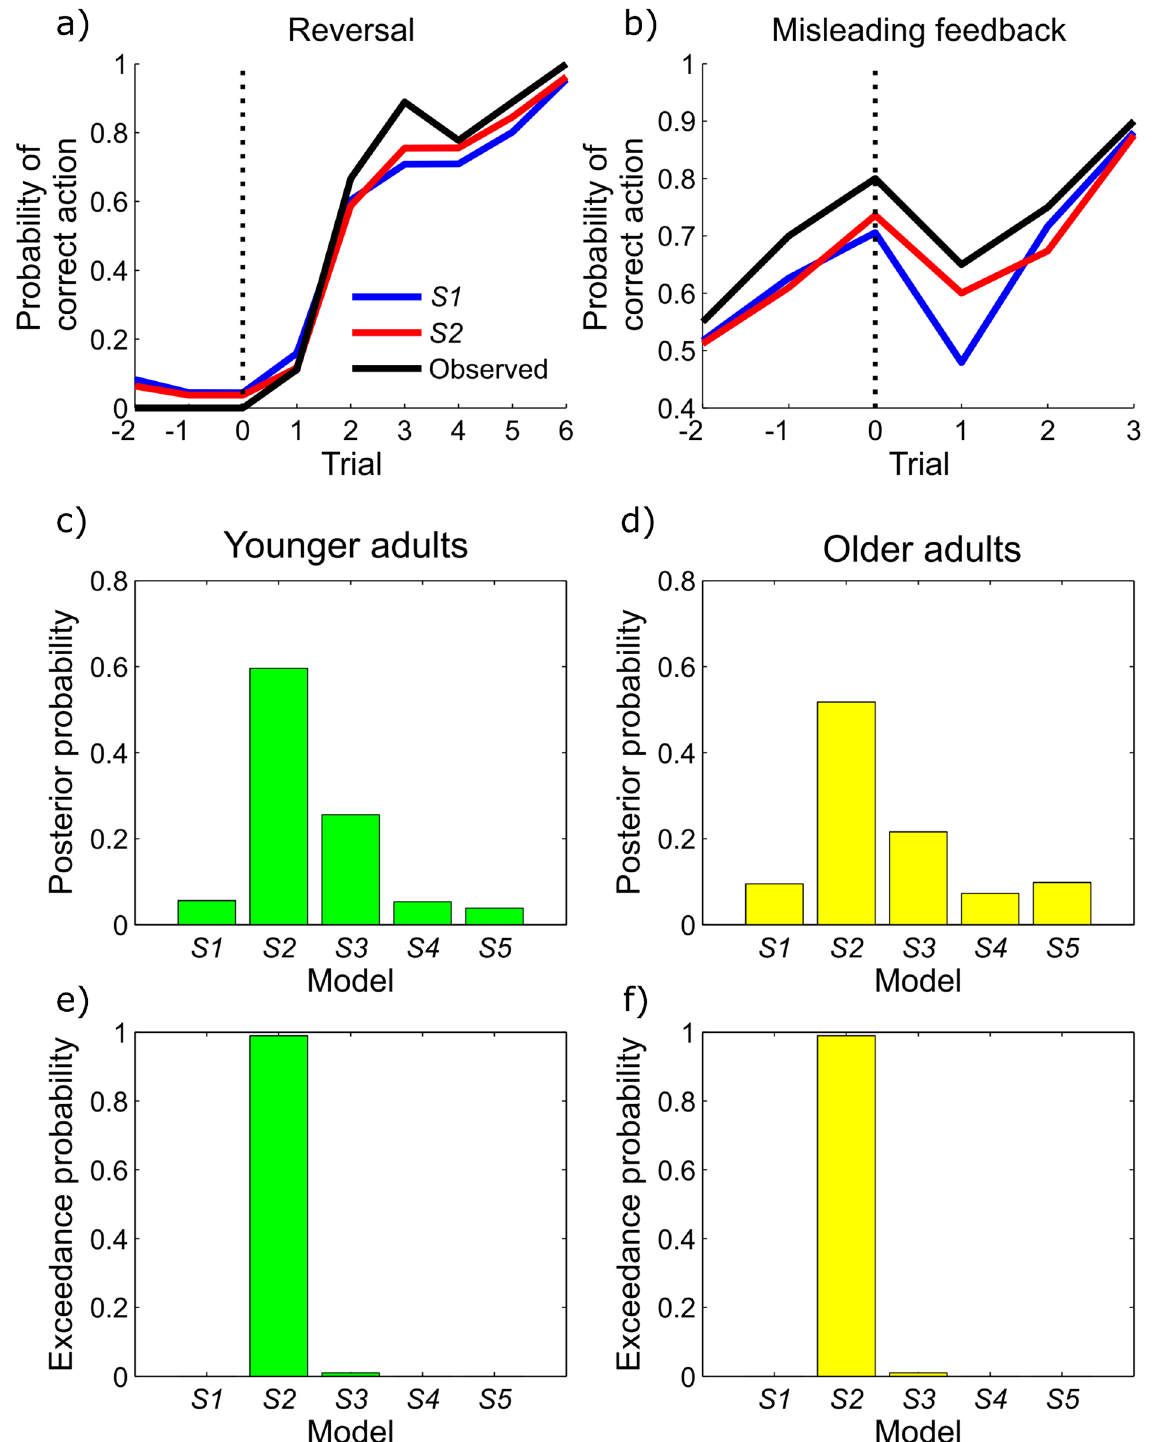
Fig 3. (a,b) Mean choice data and fitted model predictions from a single illustrative (younger)subject in whom the two state sequential inferencemodel ( S2 , red) was strongly favouredover filtering ( S1 , blue). 3a shows model predictionsand observed choices averaged across reversals. 3b shows predictedand observed behaviour averagedacross misleading outcomes (situations where the contingencies had not reversed, but improbable feedbackwas observedsuggestingthat they might have). The two state sequential inferencemodel provides a better fit to the observedchoice data (black) than the filtering model becauseit permits a